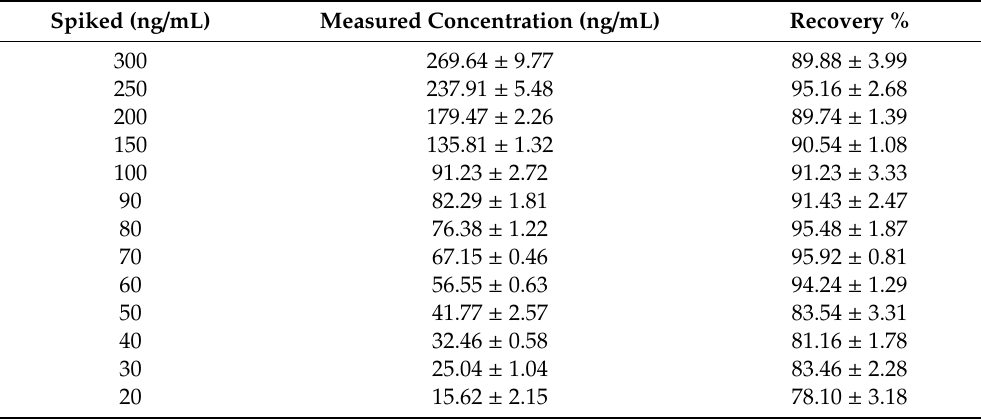
Table 2. Testing of milk sample spiked with